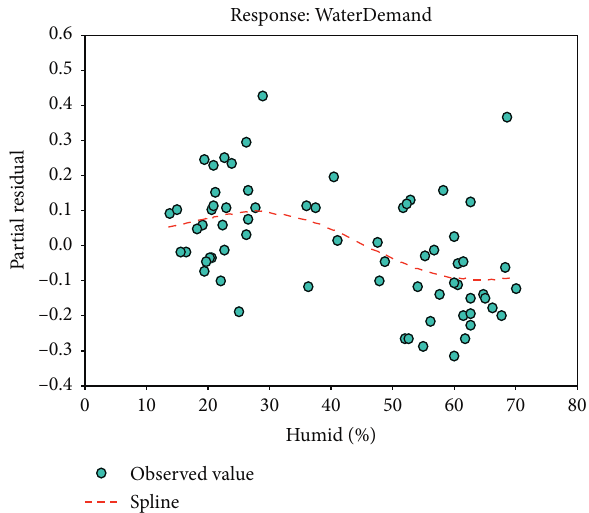
Figure 6: The individual response of the water consumption to relative